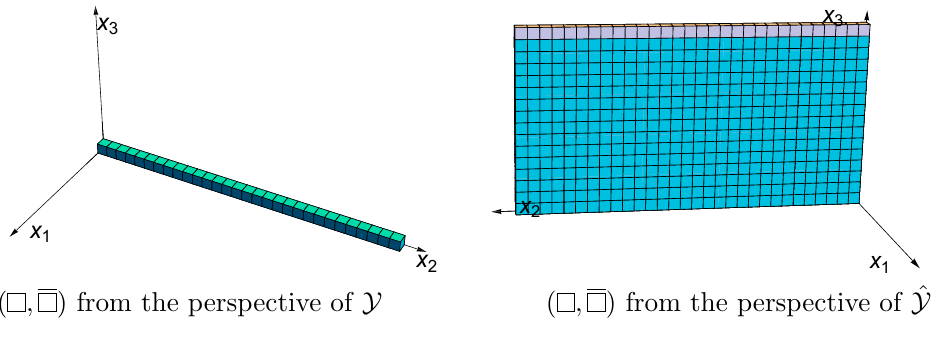
(cid:4) in terms of twin plane partition. j i